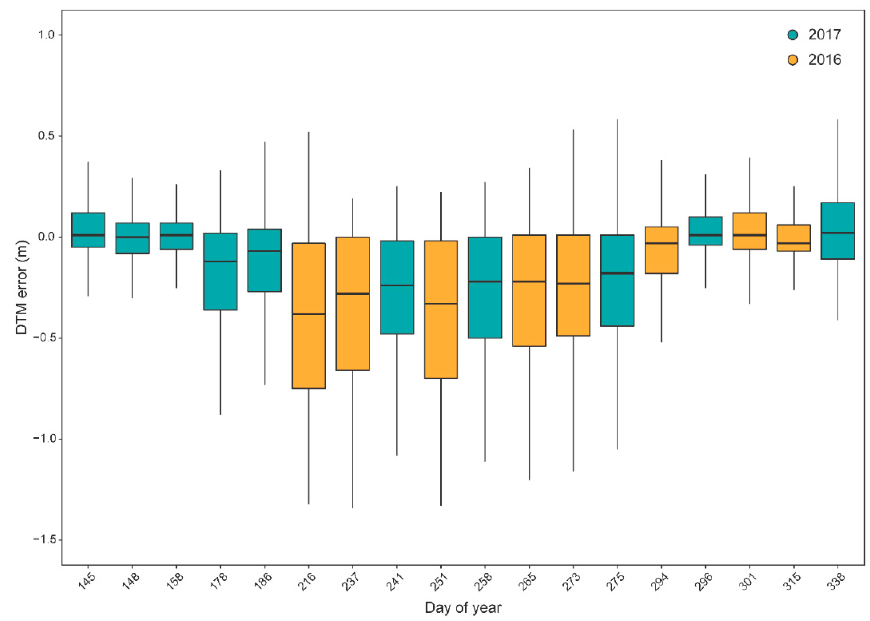
Figure 4. Boxplots of DTM error by day of year, coloured by acquisition year.